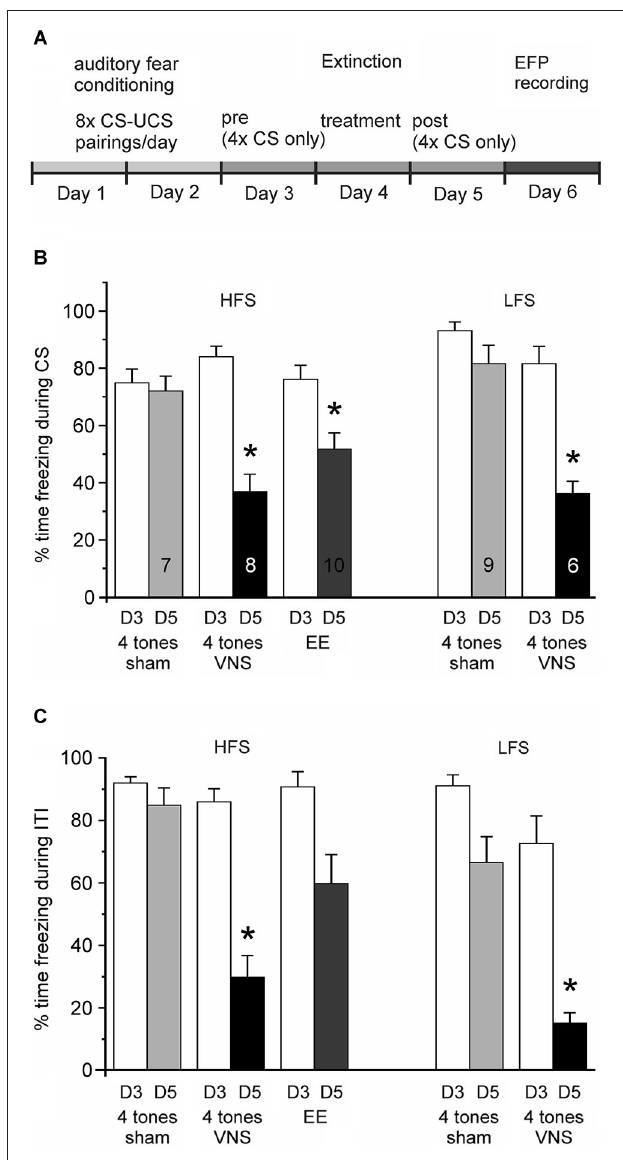
FIGURE 2 | Vagus nerve stimulation enhances extinction of auditory fear conditioning. (A) Experimental timeline. Auditory fear conditioning consisted of 2 days of training with eight pairings between a tone (CS) and a footshock (UCS) per day. On Day 3 rats were exposed four times to the conditioned tone in the absence of footshock and freezing levels were tested (Conditioned Fear Test). On Day 4 (Treatment) rats received group-specific treatment: four tone presentations were paired with either VNS or sham-stimulation. Rats in the extended-extinction group received 20 tone presentations. Freezing levels were tested again on Day 5 in response to four presentations of the CS alone (Post Treatment test). (B) Percentage of time spent freezing during presentation of the conditioned stimulus (CS) on Day 3 (D3, white bars) and Day 5 (D5), respectively, for the different treatment groups (4 tones + sham stimulation, four tones + VNS, and extended extinction, EE, with 20 tones + sham stimulation). Presentation of the Day 3 and Day 5 freezing responses is separated into groups of rats in which subsequently the plasticity of the IL-BLA pathway was tested with either high-frequency (HFS) or low-frequency stimulation (LFS) of the IL. After 1 day of extinction training paired with VNS (black bar) rats